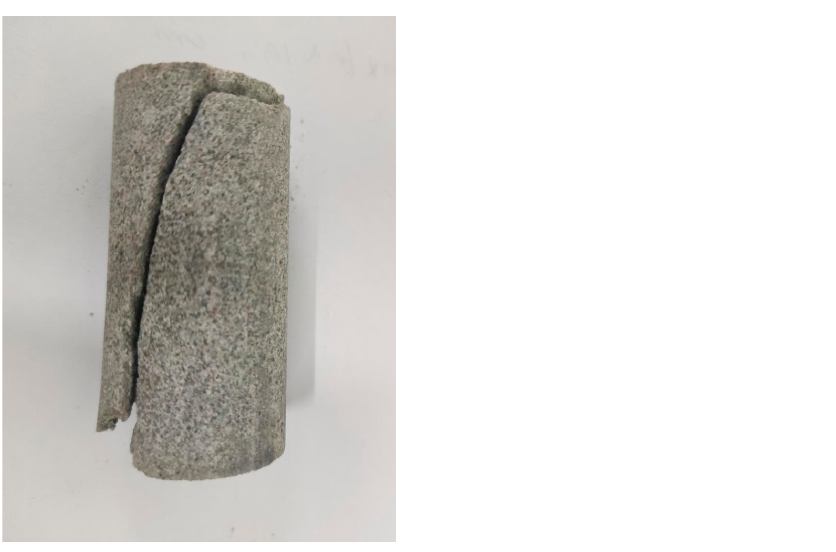
Figure 3. Triaxial compression test phenomenon of the sand hydrate sample.